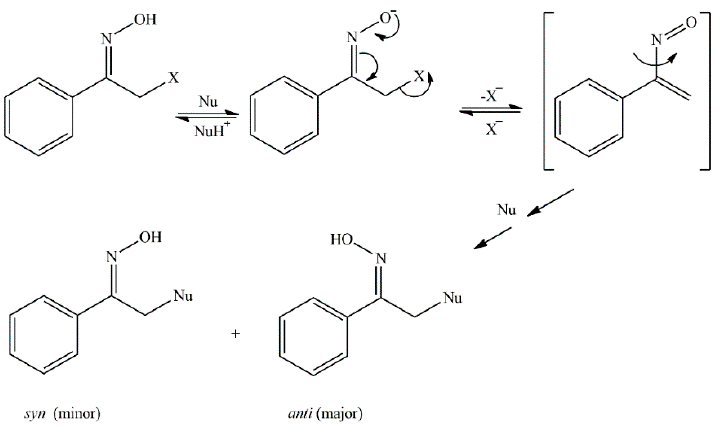
Figure 2. Schematic presentation of the S N 1 mechanism occurring in pyridoxal dioxime synthesis. Pyridoxal dioximes 1 – 7 were successfully prepared in the reaction of 2-bromoacetophenone oxime with pyridoxal monooximes while the reaction yields